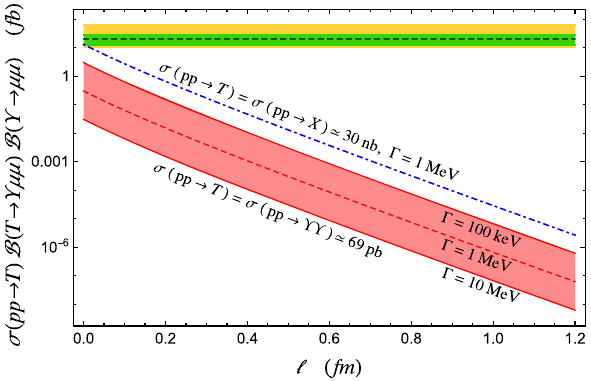
Fig. 3 Comparison between the experimental upper bounds presented in [1] (black dashed line) and the predicted value of S as a function of the size of the repulsive barrier. The green and yellow bands correspond respectively to the 1 σ and 2 σ C.L., while the red band spans different widths of the tetraquark. The red band corresponds to σ( pp → T ) = 69 pb, while the blue dot-dashed line to σ( pp → T ) = 30 nb. These results agree with [7]. A state 500 MeV below threshold [2] would have an even smaller cross